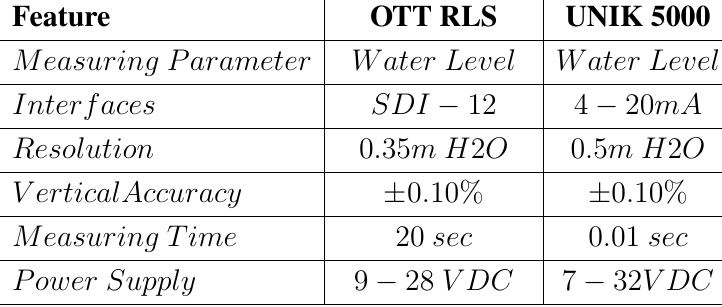
Table 1. Features of hydrologic sensors deployed in the